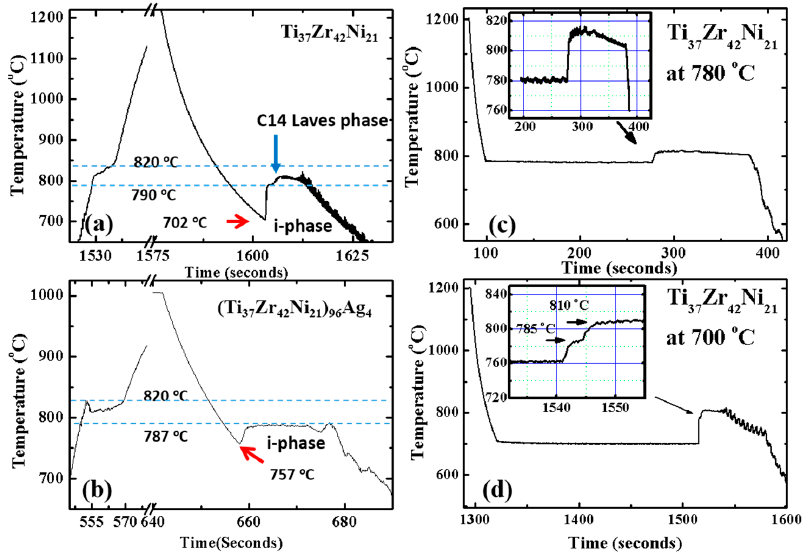
Figure 2. Temperature-time (T-t) curves measured in electrostatic levitation (ESL). A typical T-t curve forming metastable i-phase and C14 Laves phase (hcp structure) on Ti 37 Zr 42 Ni 21 alloy ( a ) [8]; A typical T-t curve forming i-phase only on (Ti 37 Zr 42 Ni 21 ) 96 Ag 4 alloy ( b ) [8]; The formation of stable C14 Laves phase from undercooled liquid at 780 °C ( c ) [21]. The formation of metastable i-phase and stable C14 Laves phase at 760 °C ( d ) [21]. Table 1. A degree of supercooling, interfacial free energy, Turnbull coefficient, nucleation barrier, critical nuclei radius of Ti 37 Zr 42 Ni 21 and (Ti 37 Zr 42 Ni 21 ) 96 Ag 4 alloys [8].